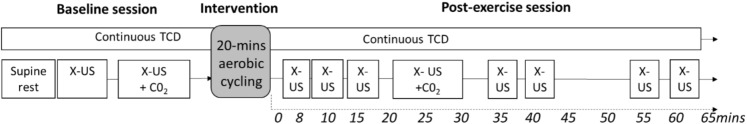
Study Design. Measures were recorded up to 65-min after exercise cessation. X-US, Doppler ultrasound to assess extracranial arteries; TCD, transcranial Doppler; X-US +CO2, Doppler ultrasound to assess cerebrovascular reactivity in the extracranial arteries with a hypercapnia challenge. Baseline ultrasound (X-US) was recorded for 5 continuous minutes after a minimum of 15-min supine rest. Cycling was performed on an upright ergometer.